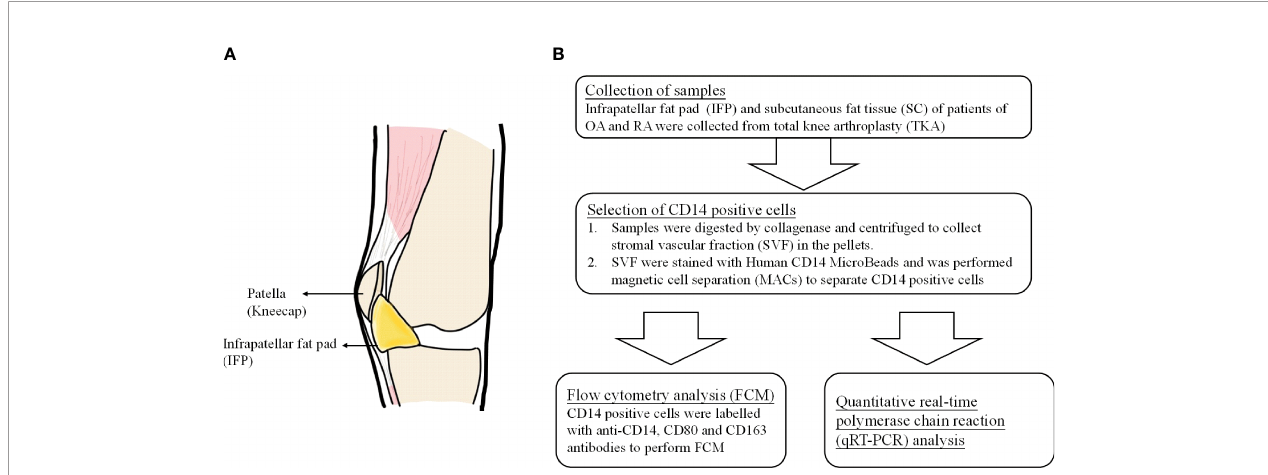
FIGURE 1 | (A) The anatomical location of infrapatellar fat pads. (B) Flow chart of the experimental